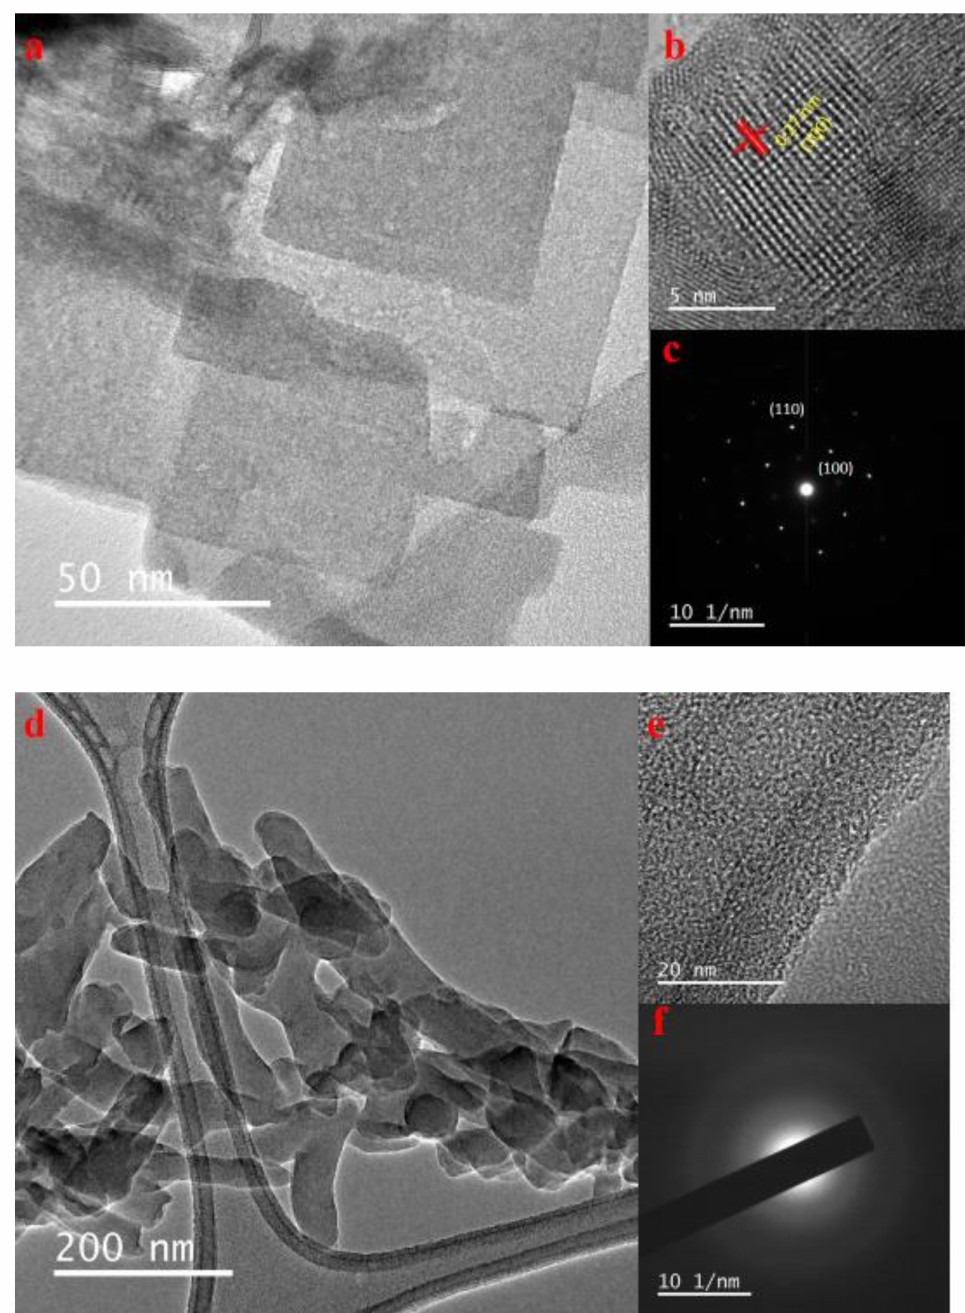
Figure 2. HRTEM images of ( a ) bare WS 2 , ( b ) bare WS 2 , ( c ) SAED pattern for bare WS 2 , ( d ) PANI nanotubes, ( e ) PANI nanotubes, ( f ) SAED pattern for bare